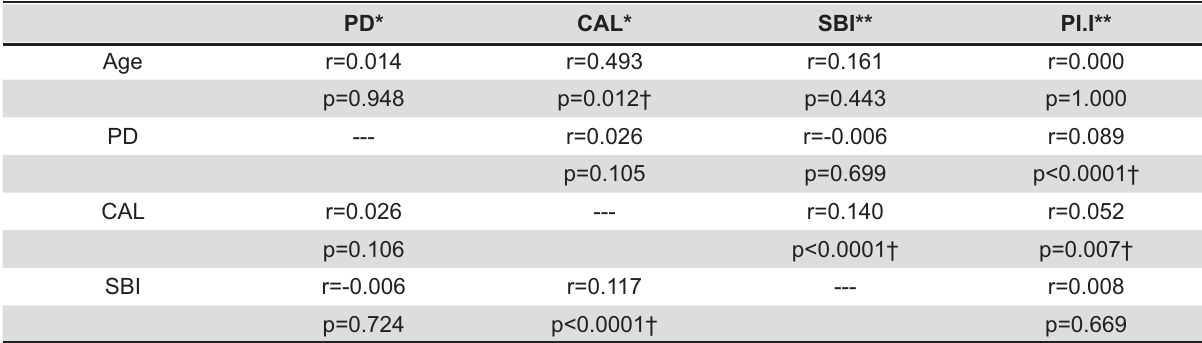
Table 3- Correlation between age and clinical periodontal parameters in the control